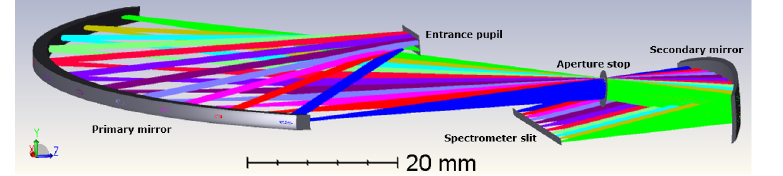
Figure 4. Optical design of our telescope. From top to bottom, the rays come from the entrance pupil (diameter = 2.52 mm), are reflected by the primary mirror (radius of curvature in X = 70.72 mm), go through the aperture stop (diameter = 2.94 mm), are reflected by the secondary mirror (radius of curvature in X = − 35.82 mm) and finally reach the spectrometer slit (length = 26.4 mm). The different colors correspond to the different fields, from − 60° to 60°, by step of 12°.